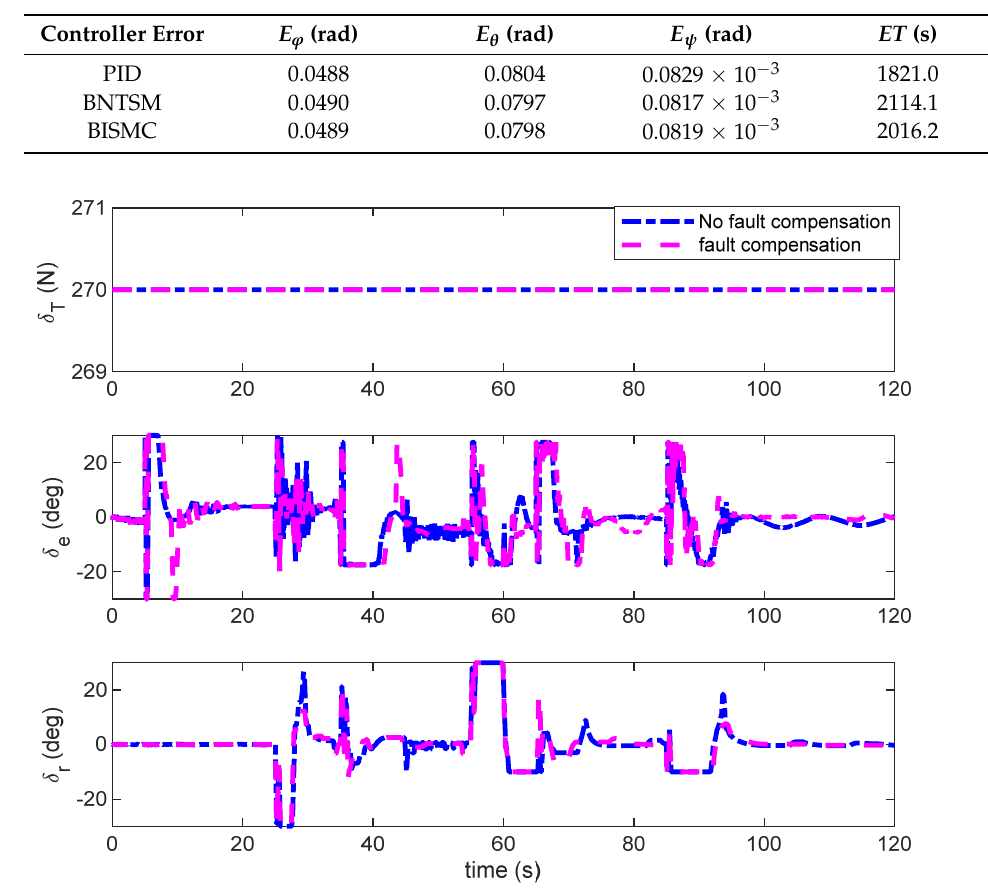
fault compensation.